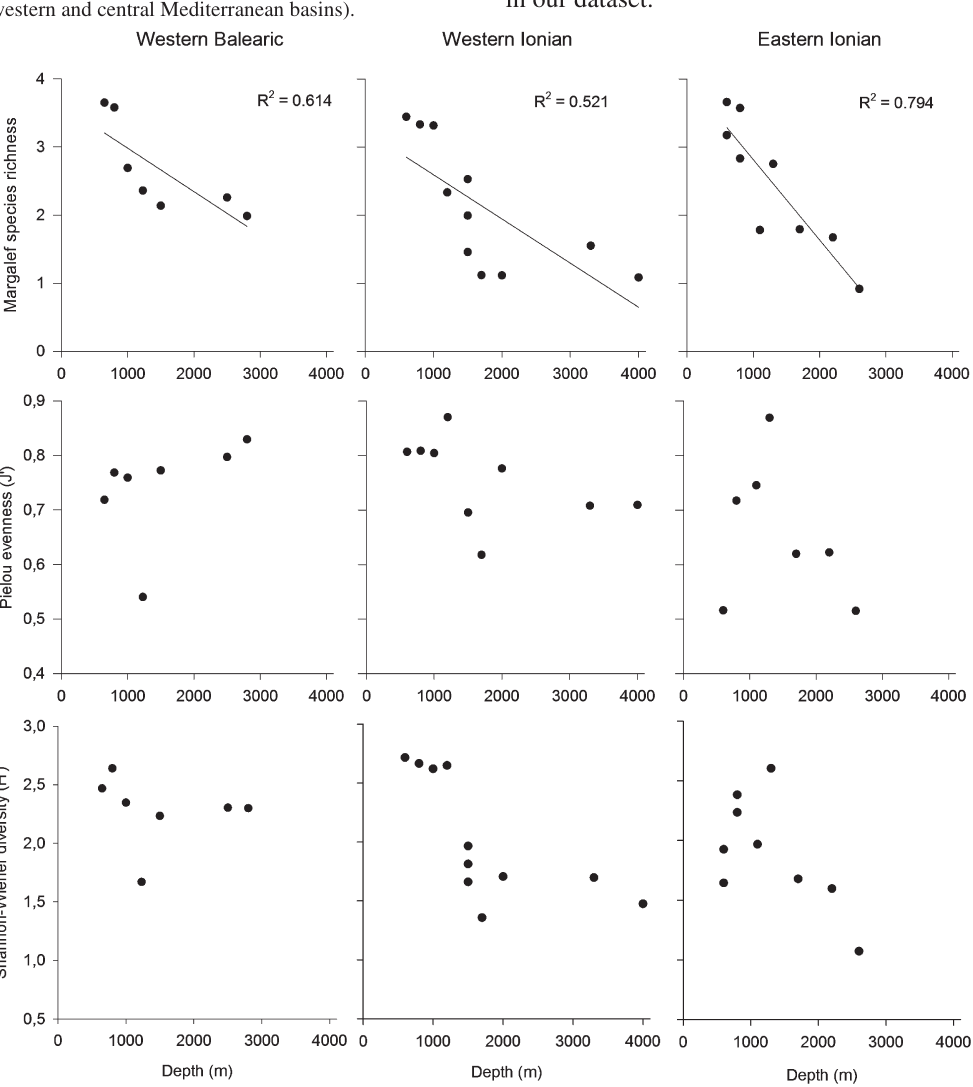
Fig . 4. – Margalef species richness, Pielou evenness and Shannon-Wiener diversity indices for the western Balearic Sea, the western Ionian sea (including the two central abyssal plain samples), and the eastern Ionian Sea. Linear regression lines are shown only when significant ( p